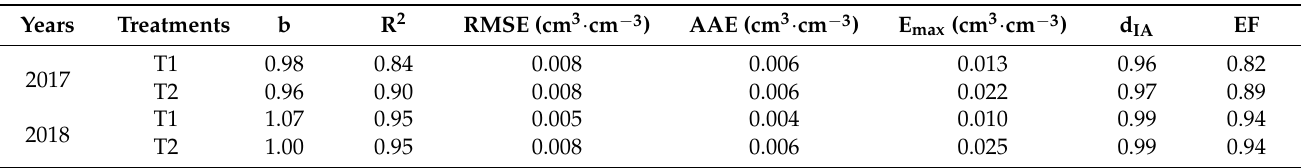
Table 4. Statistical indicators of goodness-of-fit between measured and simulated seasonal soil water content (SWC) for the two treatments (T1 and T2) in 2017 and 2018.